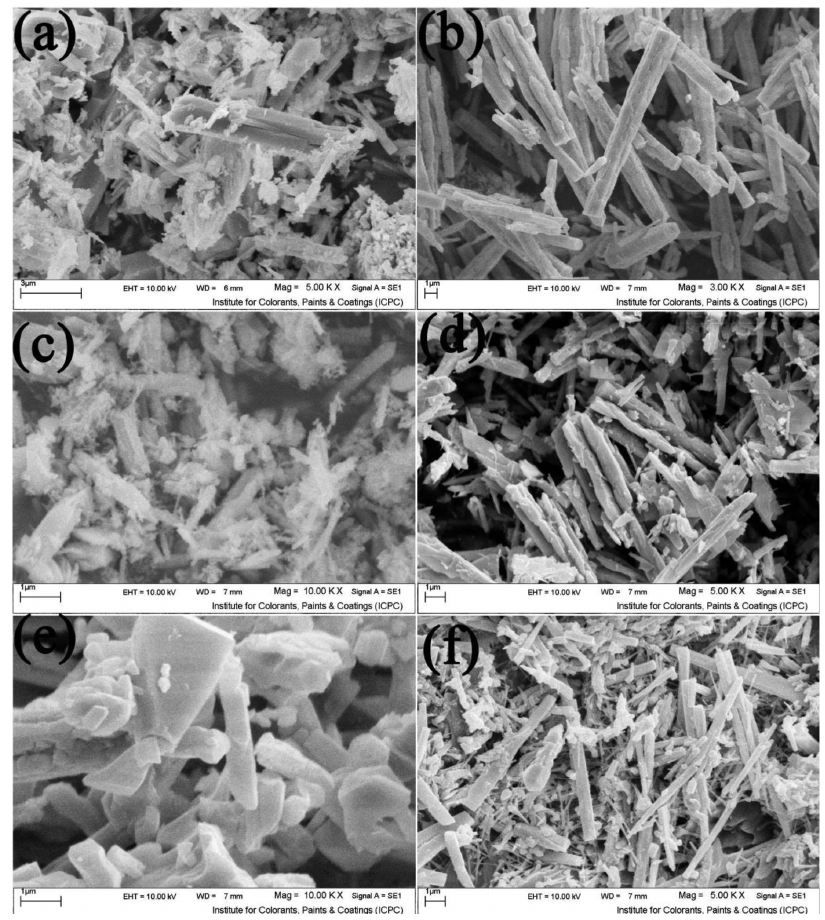
Figure 4: SEM image of (a – f) sample no. 1 – 6, respectively.